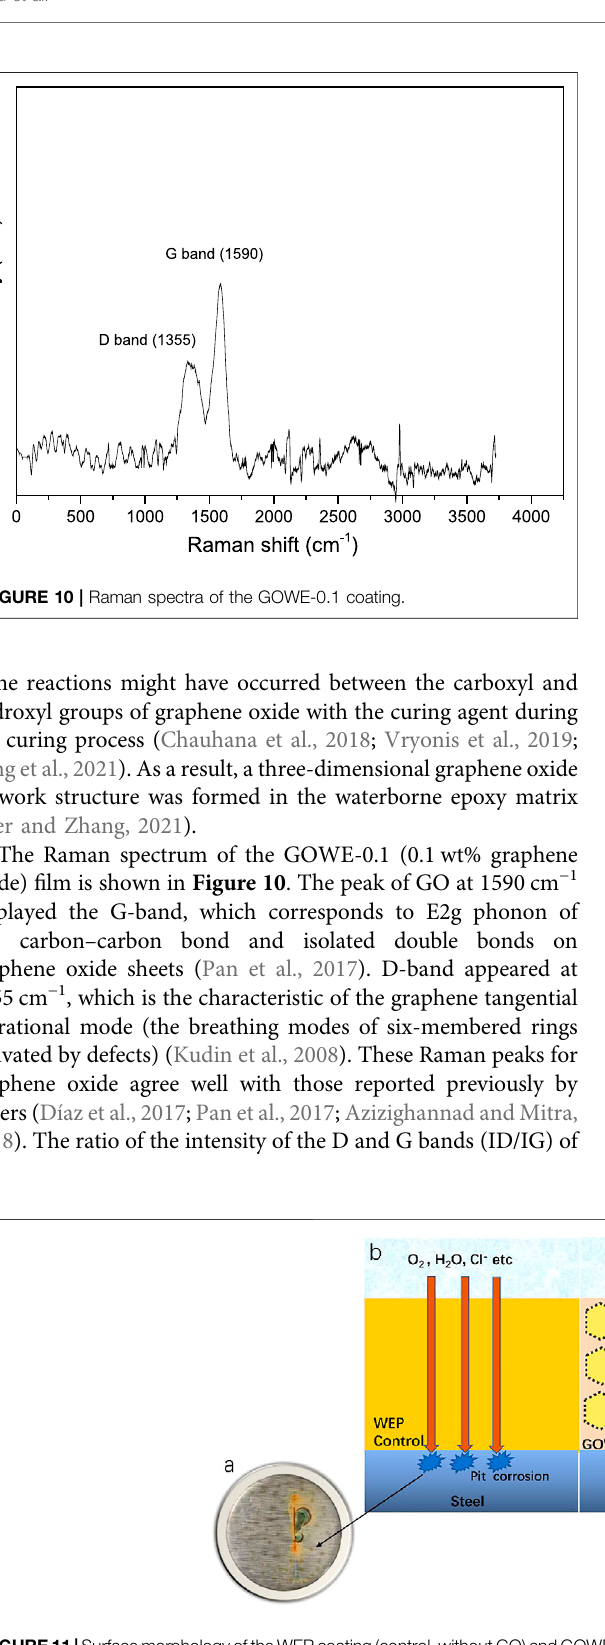
Frontiers in Materials |